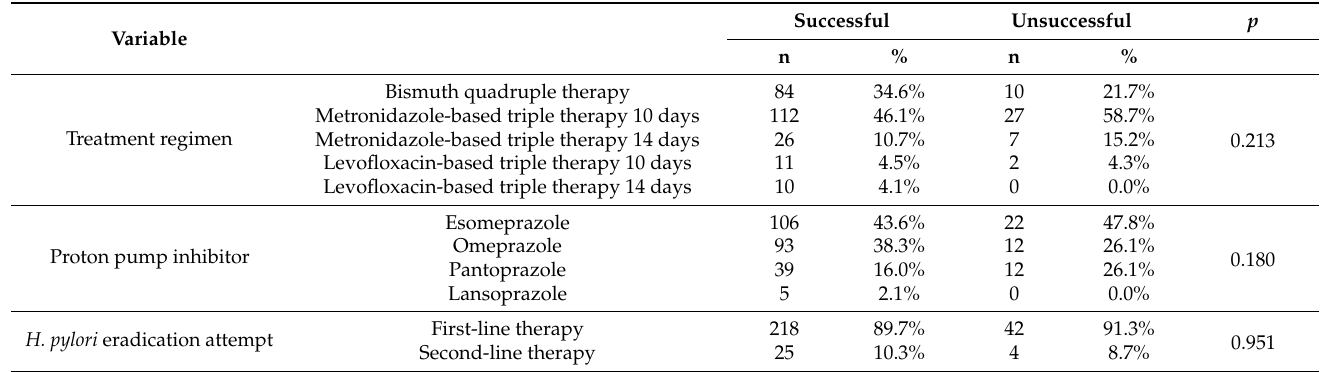
Table 2. Treatment effectiveness depending on the treatment regimen, type of IPP, treatment duration, and eradication